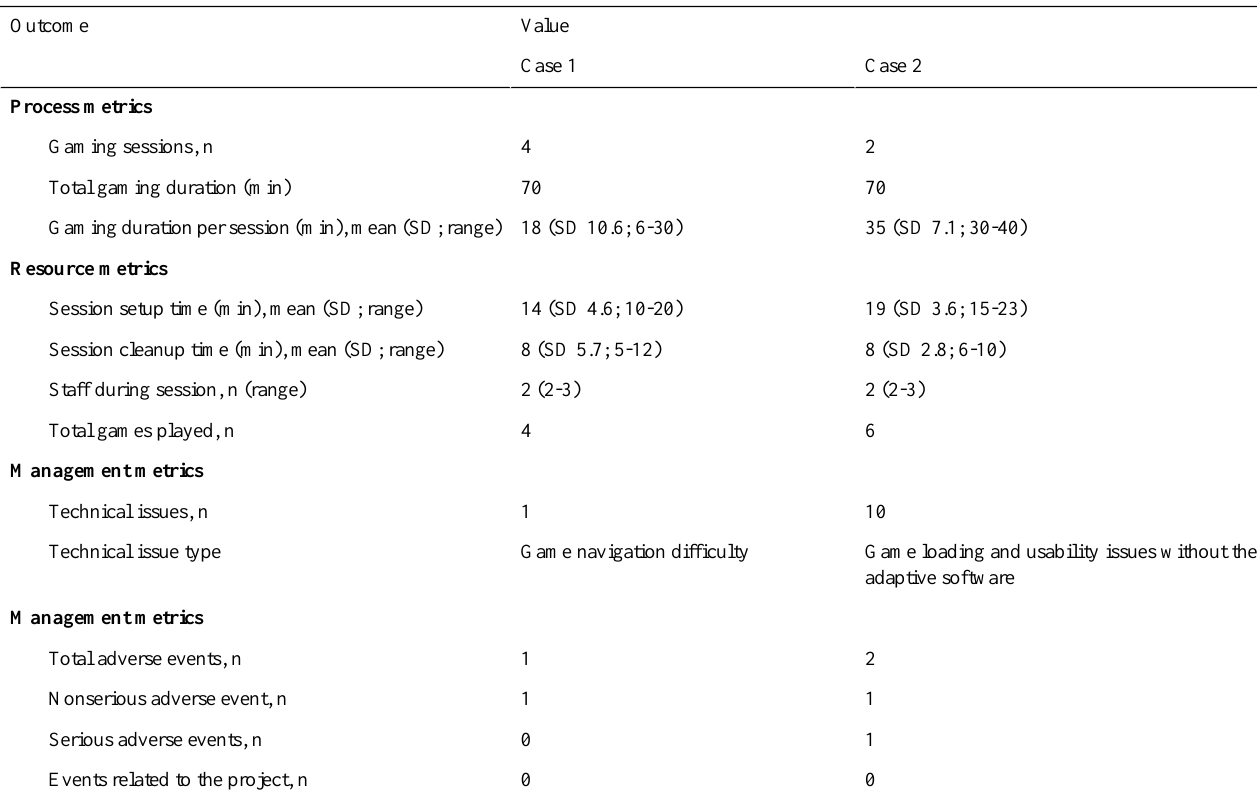
Table 2. Feasibility results